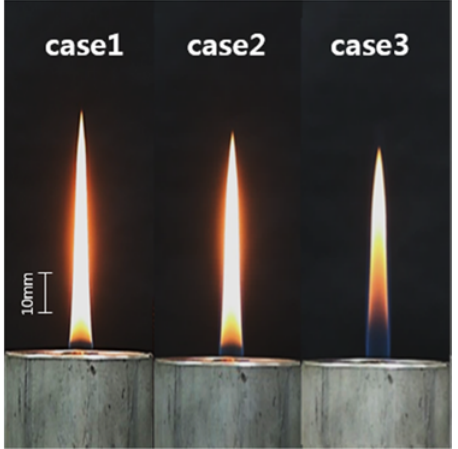
Figure 3. Flame patterns of post combustion simulated gases, including ethylene with different dilutions observed by the natural emission imaging method.